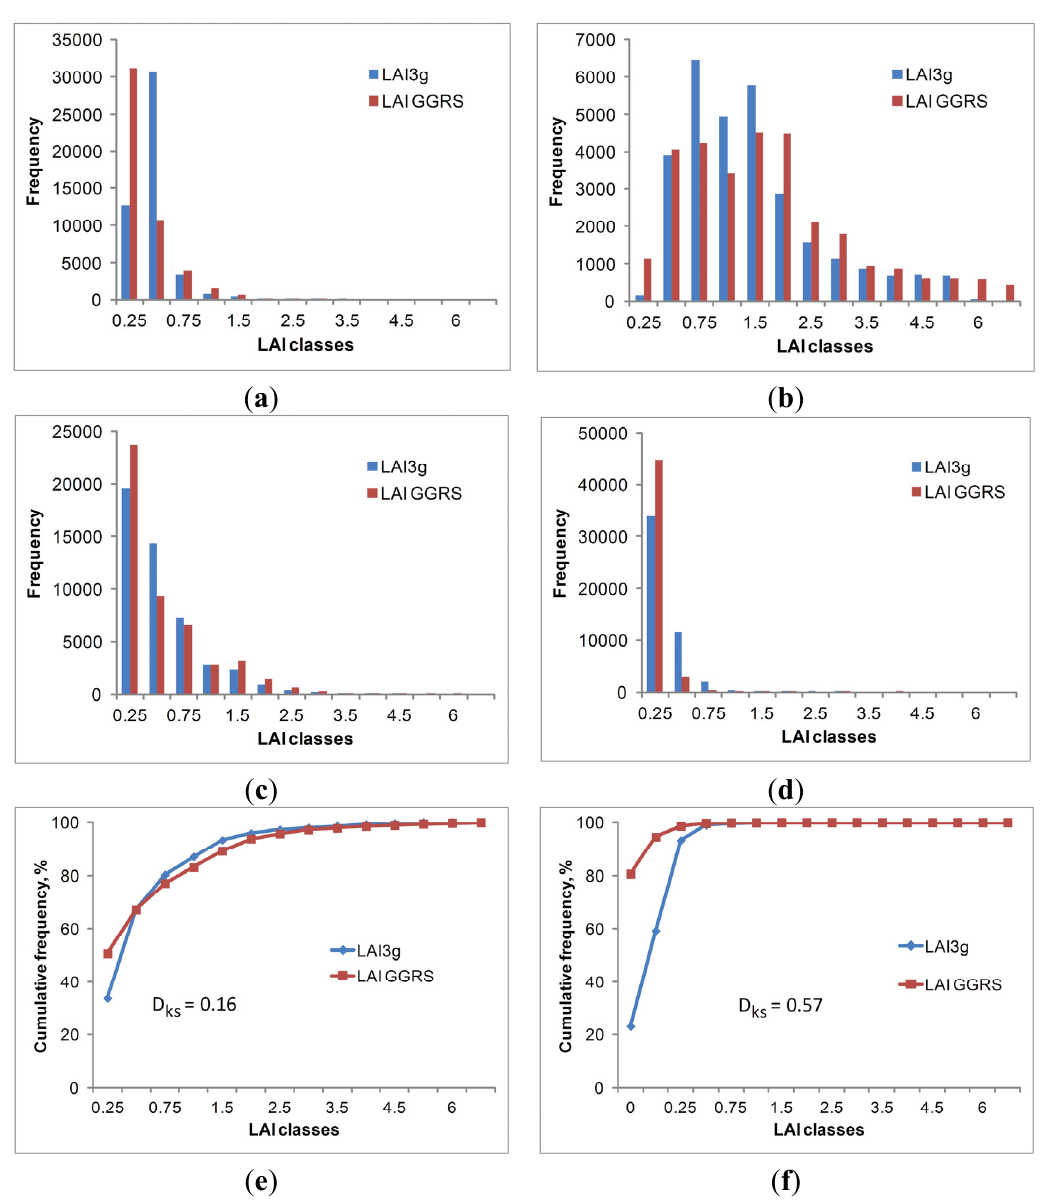
Figure 5. Comparison of the LAI3g/GGRS-LAI value distribution over Kazakhstan: distribution histograms for ( a ) April, ( b ) June, ( c ) August, ( d ) October ( e ) and ( f )